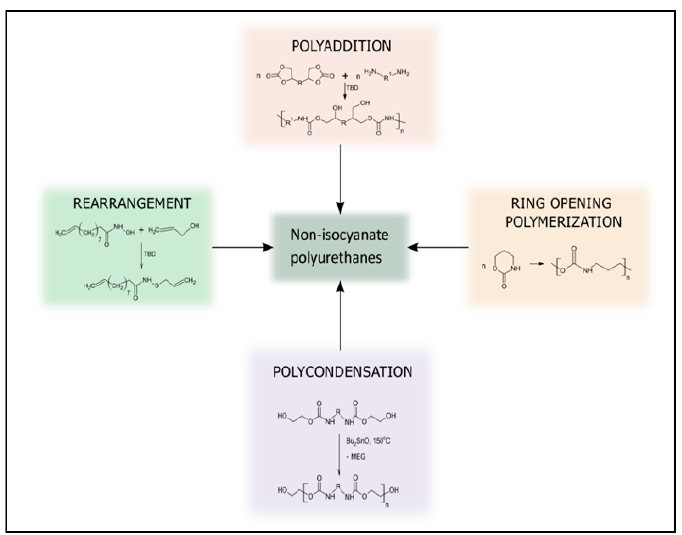
Figure 2. Different pathways used to prepare NIPU. Reprinted from ref [42] with permission from the publisher.